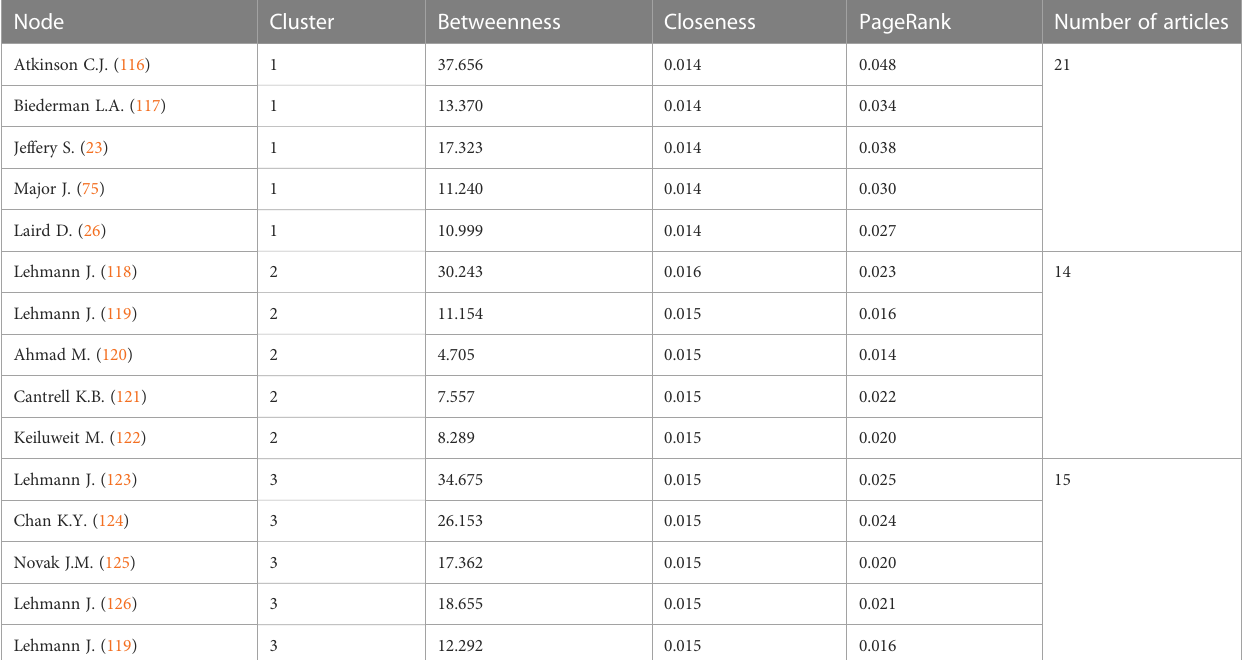
TABLE 5 Cluster of